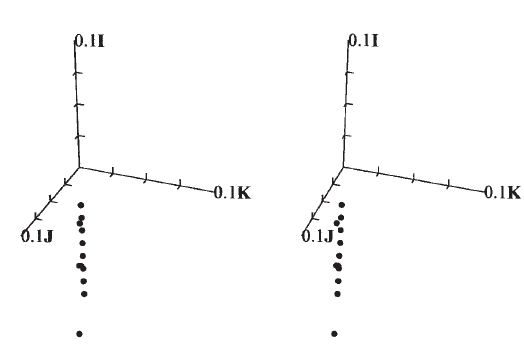
Figure 1a. Scatter plot of 50 measurements of refractive state of a test eye. Origin of axes is set at − 5 D for this and all sub- sequent figures. Operator refocused the instrument after each measurement and decided when to trigger the measurement. Length of axes: 0.1 D. For details see text.